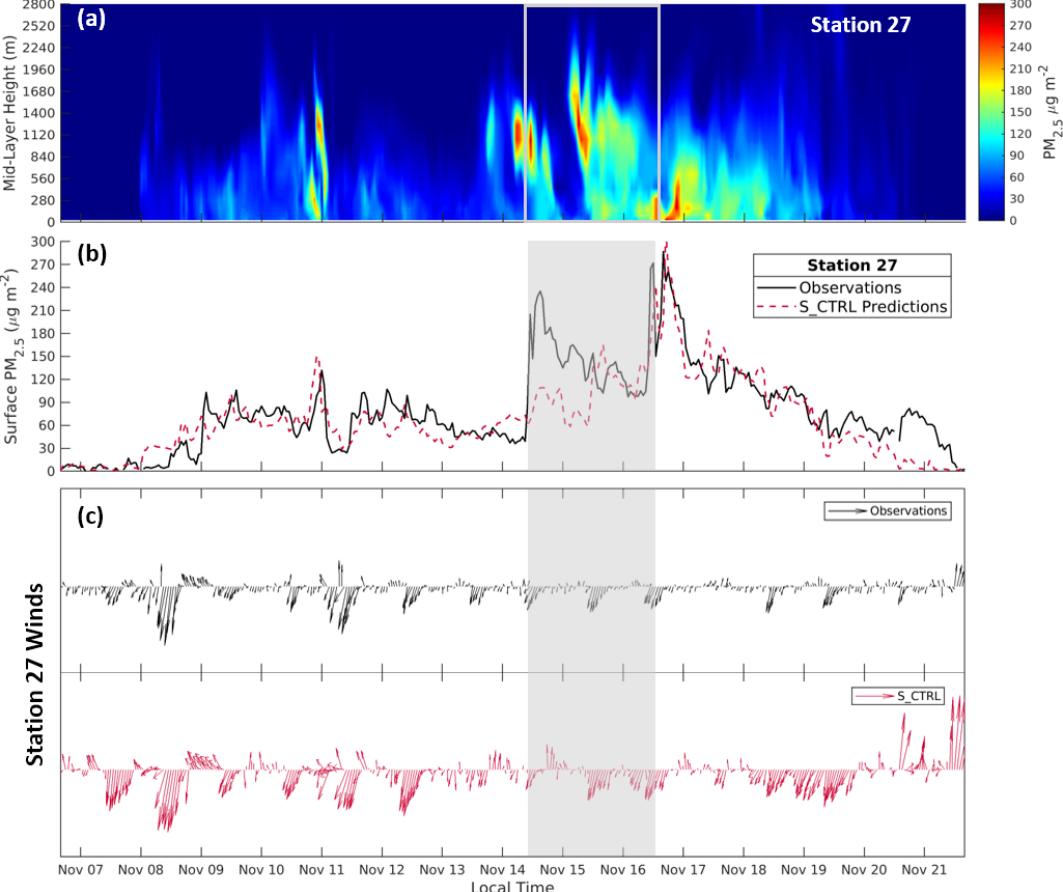
Figure 9. Vertical profile of PM 2 . 5 (a) , time series of surface PM 2 . 5 (b) , and winds ( c ; observations in black and predictions in red) at Station 27 in the Bay Area. The gray box highlights the time frame of greatest model bias of surface PM 2 . 5 . Sharp increases in PM 2 . 5 correlate with a switch to northeasterly winds that import fire emissions to the Bay Area. A large negative PM 2 . 5 bias on 15 November occurs when S_CTRL deviates from observations and produces southerly winds which bring in clean air. This can be seen in the column of low-level PM on 15 November in panel (a)